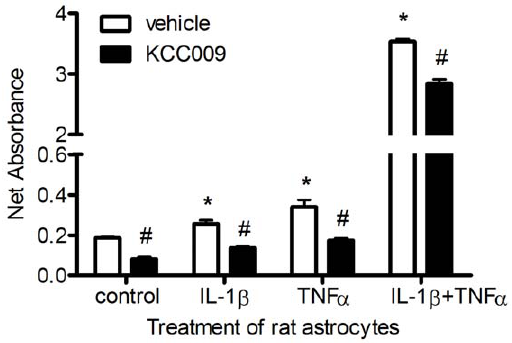
Figure 3. Incorporation of BAP into Fn by rat astrocyte-derived TG2. Data represent mean values 6 s.e.m. from a representative experiment, n=5 for each data point. *P , 0.05 versus vehicle-treated control cells, # P , 0.05 versus vehicle-treated control or matched cytokine-treated cells.